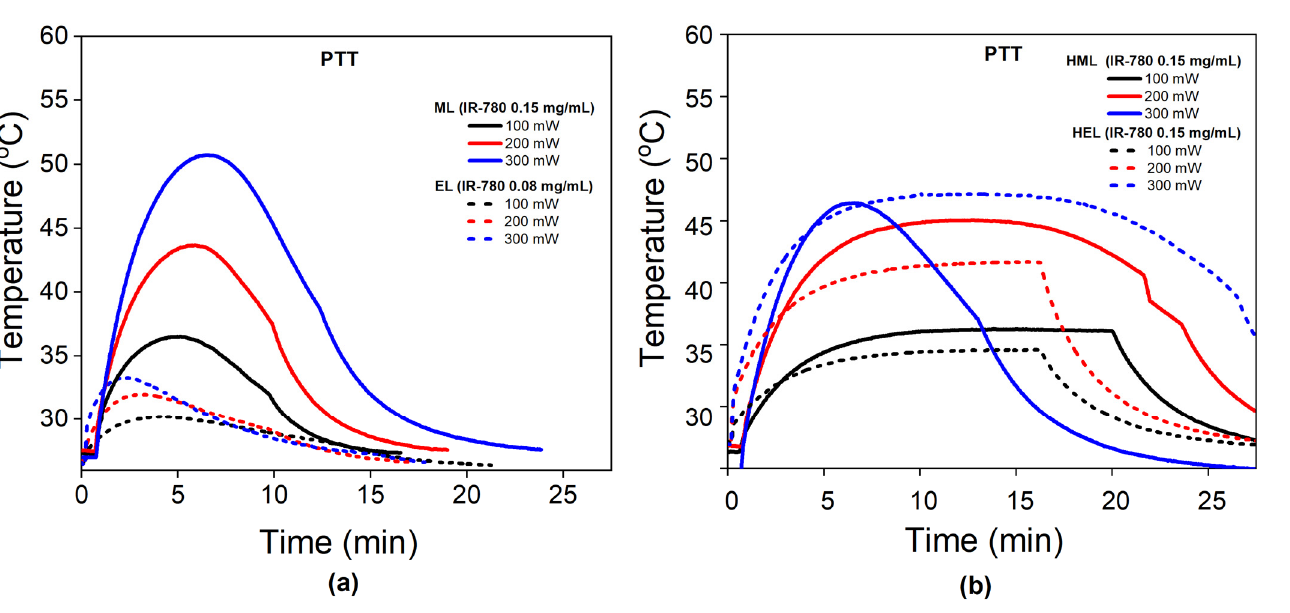
Figure 4. The influence of membrane type on PTT: ( a ) Temperature profile during PTT for cell membrane nanoparticles at different laser powers (100, 200 and 300 mW). Dashed lines represent erythrocyte vesicles (ELs), while solid ones indicate melanoma liposomes (MLs). ( b ) Temperature profile during PTT for hybrid nanoparticles at different laser powers (100, 200 and 300 mW). Dashed lines represent hybrid erythrocyte vesicles (HELs), while solid ones indicate hybrid melanoma liposomes (HMLs).